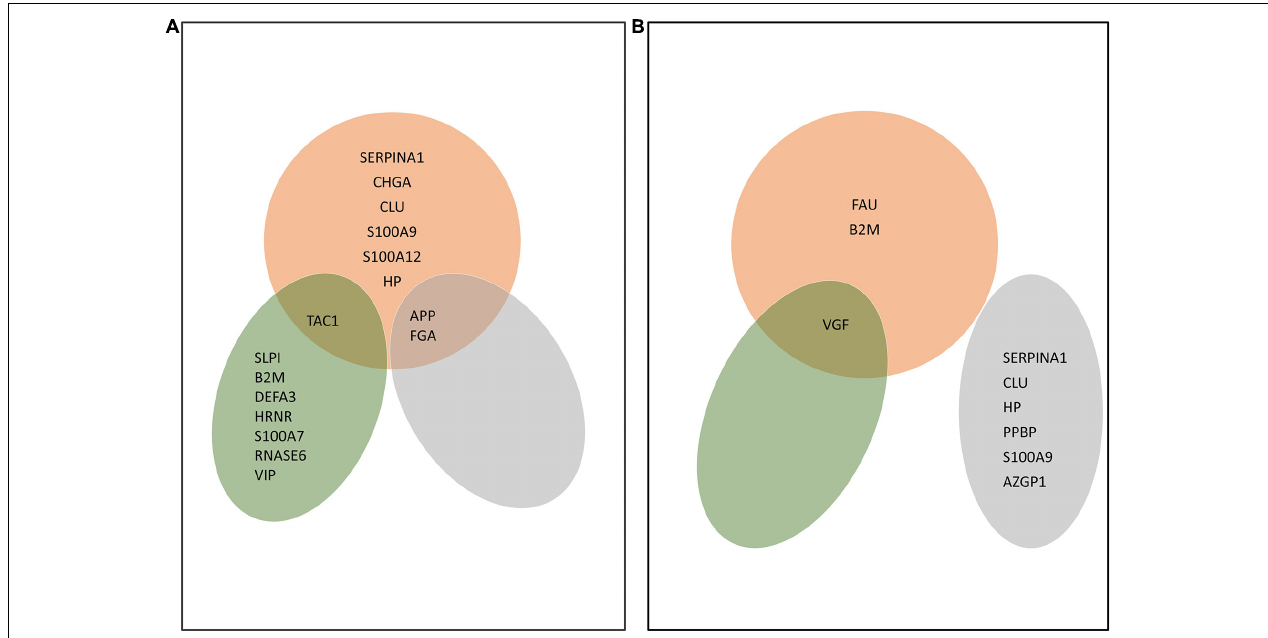
FIGURE 3 | AMPs characteristic of Alzheimer’s disease (AD) in the brain, CSF, and blood. (A) AMPs whose amount increased in a statistically significant manner in AD compared with the control. (B) AMPs whose amount dropped in a statistically significant manner in AD compared with the control. The Venn diagrams shows the proteins corresponding to each group. Red color shows AMPs found in brain, green refers to AMPs identified in CSF, while gray shows AMPs found in blood. The proteins are shown according to their gene names.